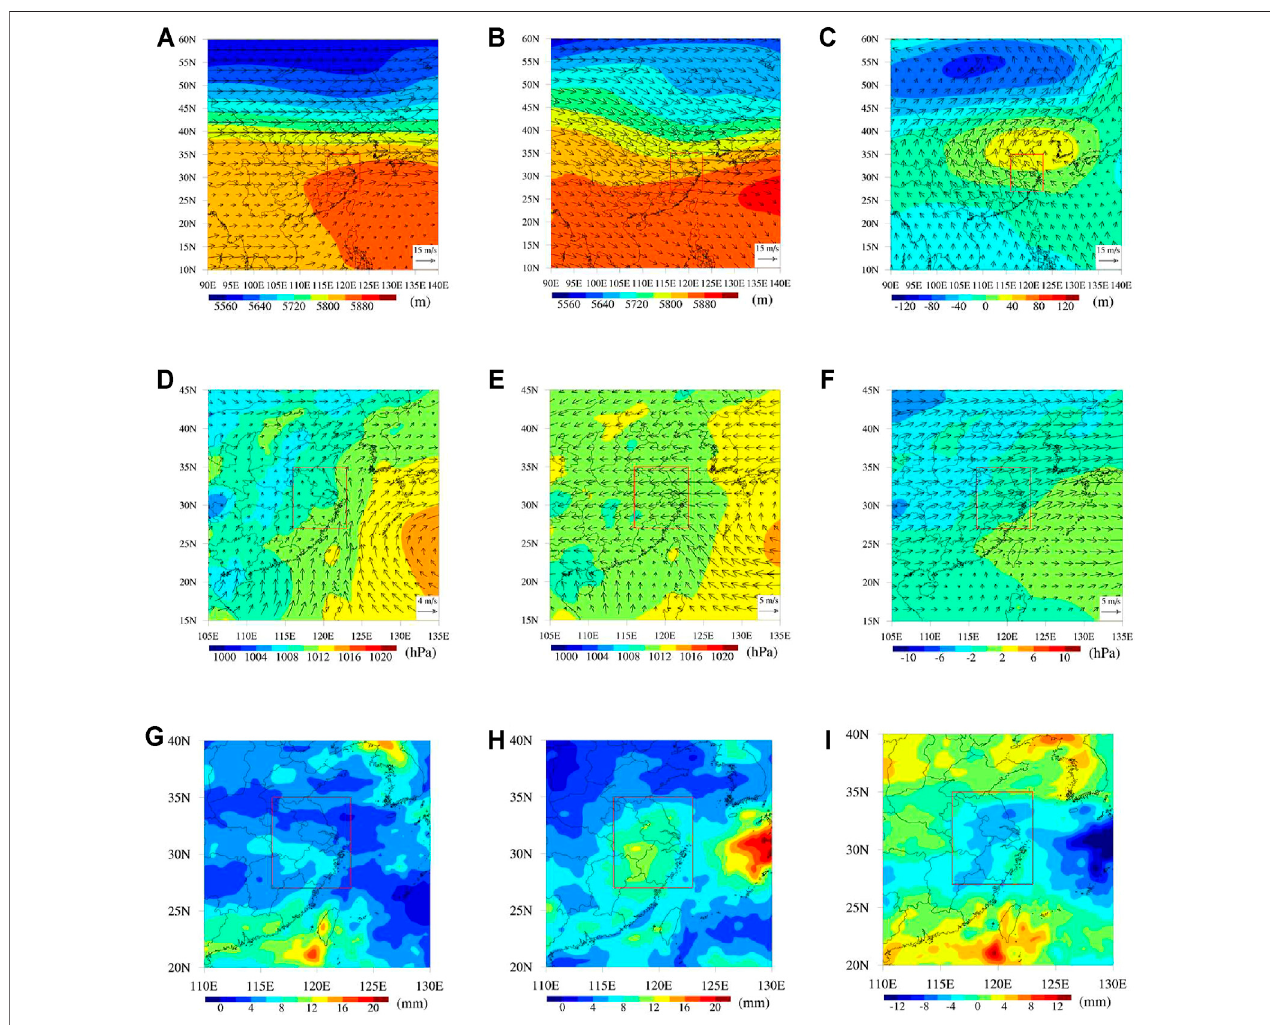
FIGURE8| Thesummertimeaveragesforthethreemeteorologicalvariablesidentifyinganairstagnationday,includingthe fi eldsofgeopotentialheightandwindat 500 hPa atmospheric layer (A – C) , the sea level pressure fi eld and 10 m wind fi eld (D – F) , and the precipitation (G – I) . (A) , (D) , and (G) show the results in 2013. (B) , (E) and (H) show the results in 2015. (C) , (F) , and (I) show the differences between 2013 and 2015. In (A – I) , the red rectangular region indicates the YRD.